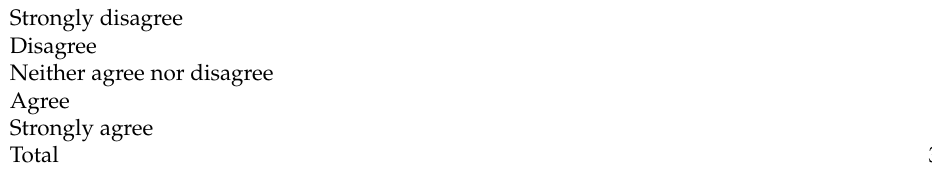
Table 2. I wish to migrate abroad sometime in the future.